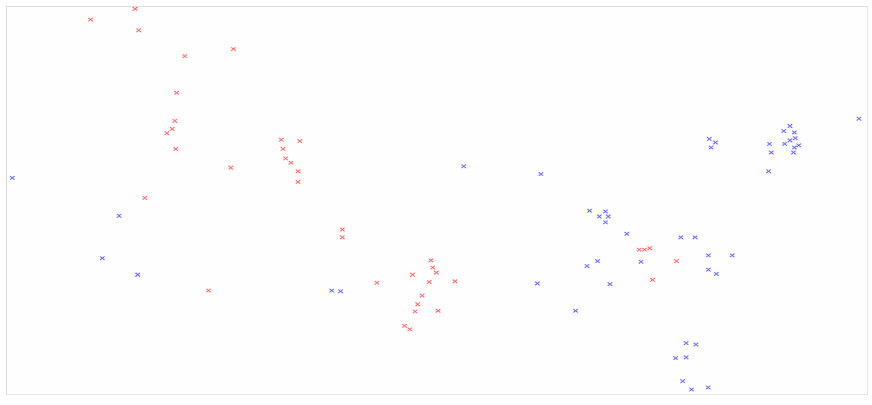
Figure 5: From WEKA: Subset B (cid:21) 89 Counties